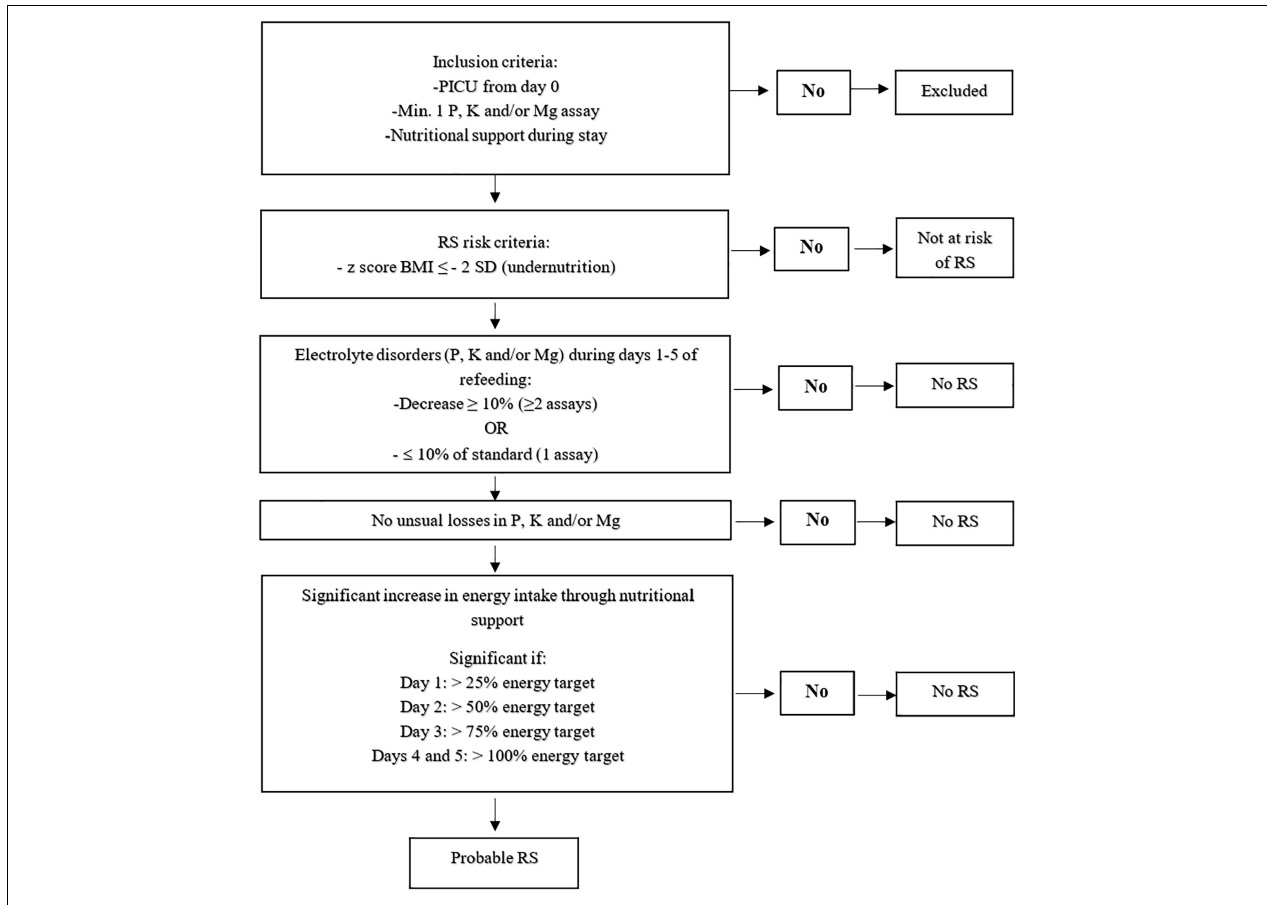
FIGURE 1 | Refeeding syndrome assessment methodology. BMI = Body Mass Index, K = Potassium, Mg = Magnesium, P = Phosphorus, PICU = Pediatric Intensive Care Unit, RS = Refeeding Syndrome, SD = Standard